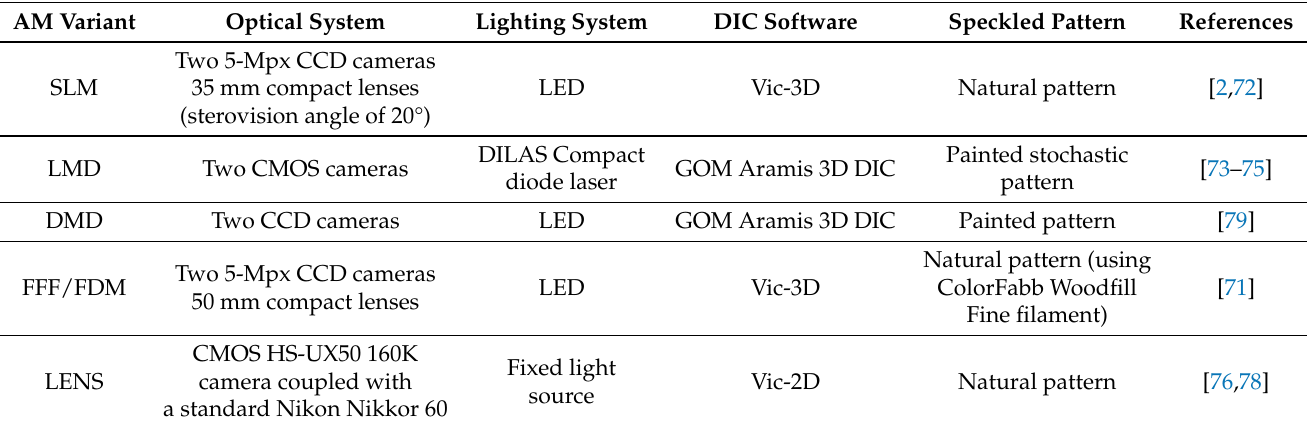
Table 2. Optical system, lighting and speckled pattern employed during AM